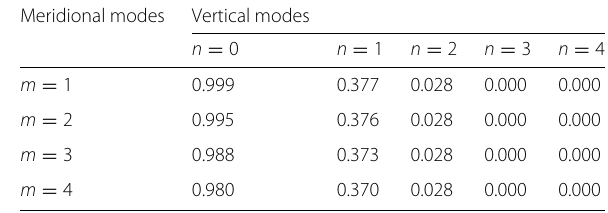
Table 2 Dependence of the correlation coefficients between the observed and simulated SSH at station K2 on the eddy